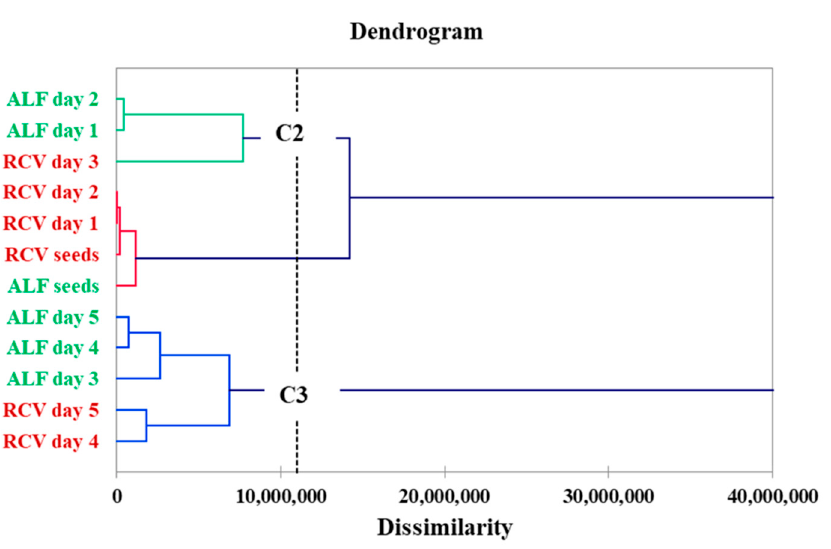
Figure 5. Dendrogram of the ALF and RCV sprouts samples during 5 days of germination: C1, 2, 3—classes grouped by dissimilarities criteria.